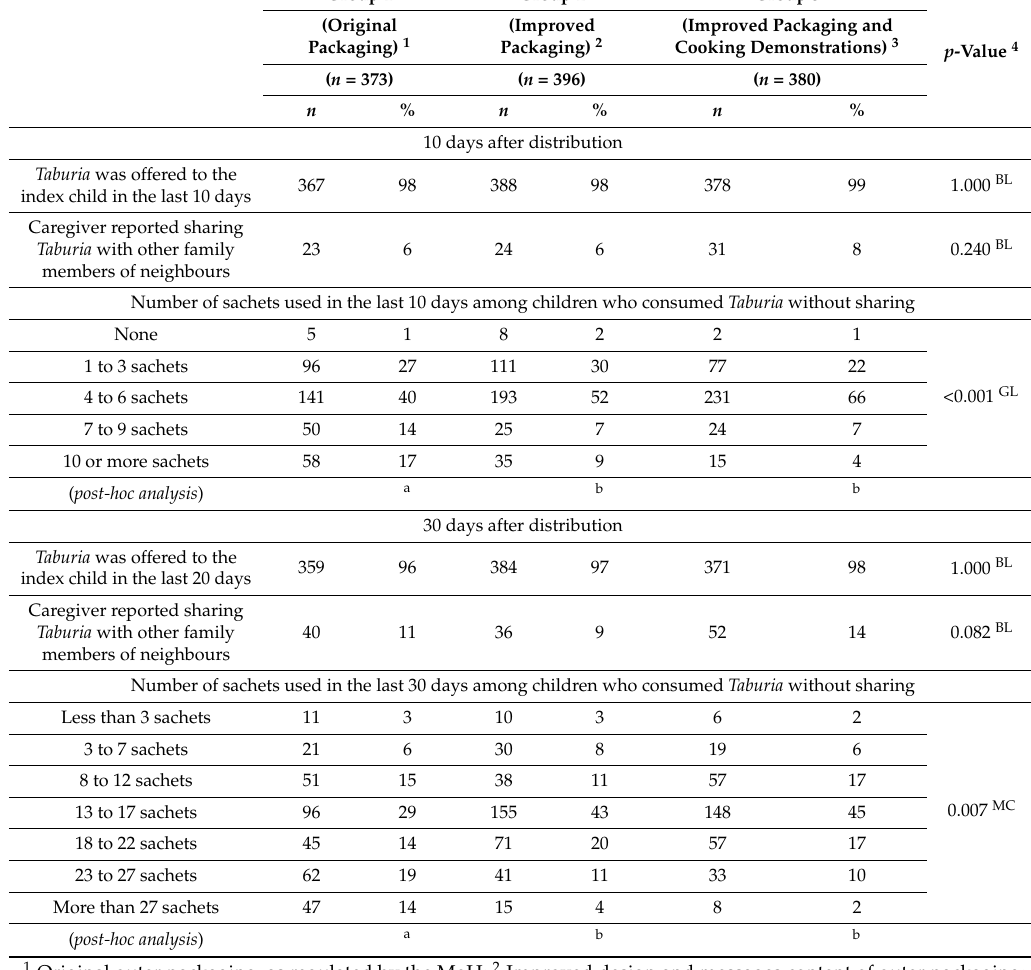
Table 5. Adherence with prescribed use of Taburia 10 and 30 days after distribution. Group